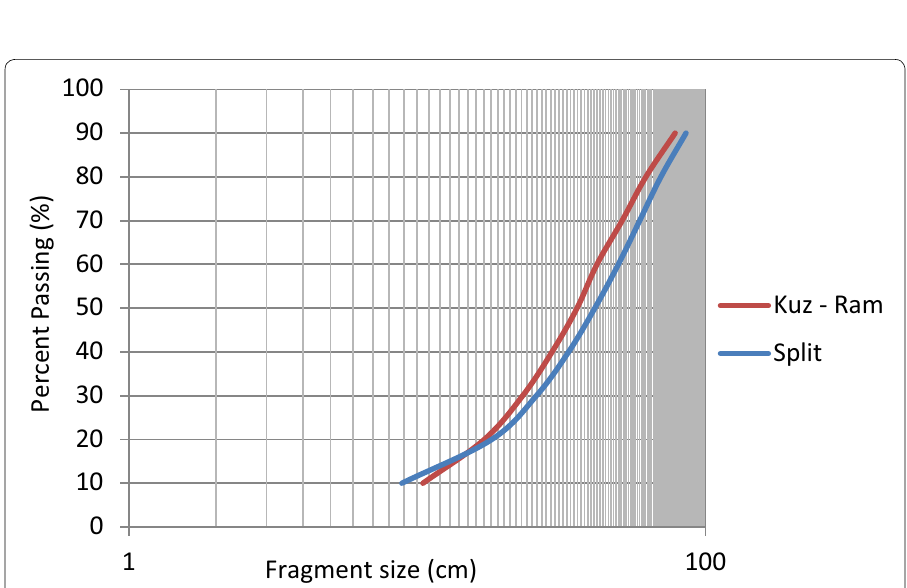
Fig. 6 Diagram obtained from the Kuz-Ram experiential model and digital image analysis in Split Desktop for pattern No.